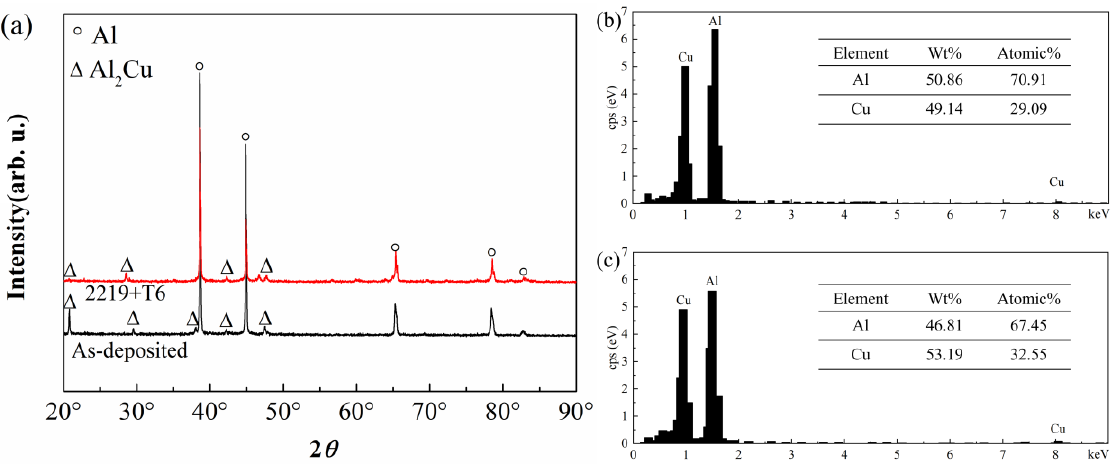
Figure 6. ( a ) XRD pattern of WAAM 2219 alloys; EDS analysis for the second phase in the WAAM 2219 alloys ( b ) as-deposited and ( c ) T6 heat-treated.